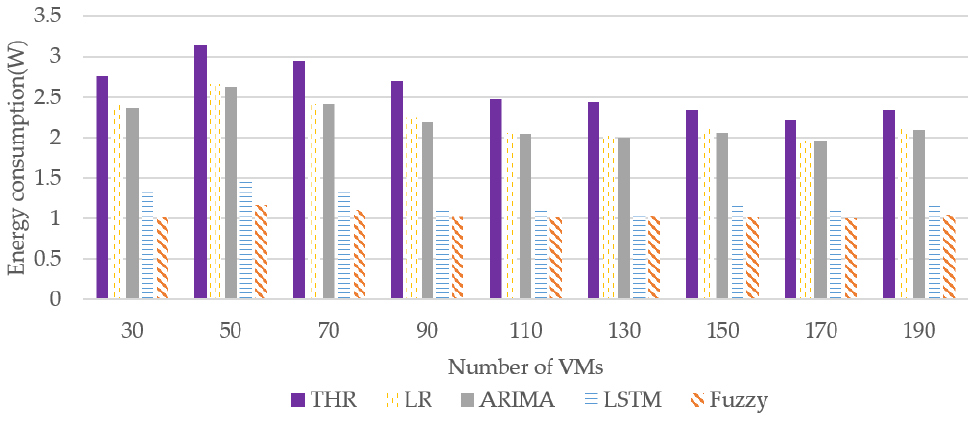
Figure 15. Energy consumption by policy.